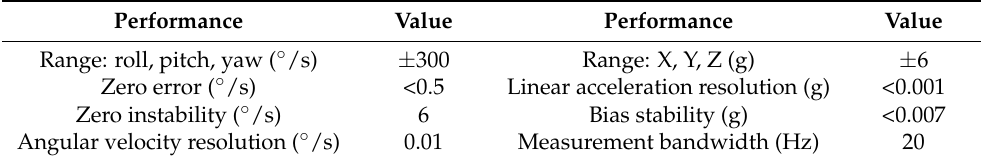
Figure 9. Experimental platform of six-axis accelerometers. ( a ) Arrangement of test instruments; ( b ) Measurement scheme 1; ( c ) Measurement scheme 2; ( d ) Measurement scheme 3. Table 3. Inertial measurement unit (IMU) performance indicators.